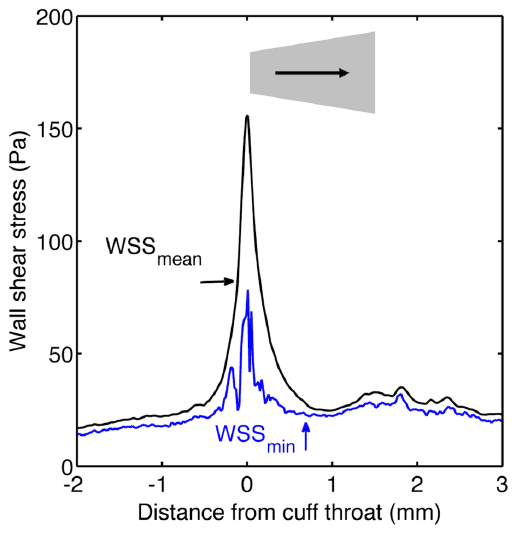
Fig. 7. Mean and minimum WSS along vessels with the cuff in the reverse orientation. Plot equivalent to Fig. 6 but for the mouse with the cuff in the reverse